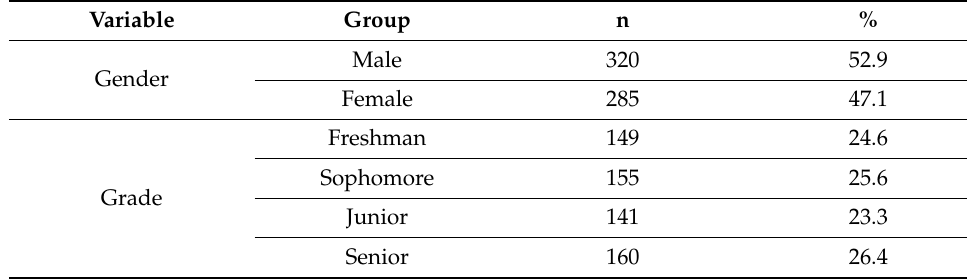
Table 1. Descriptive statistics of participants (N =